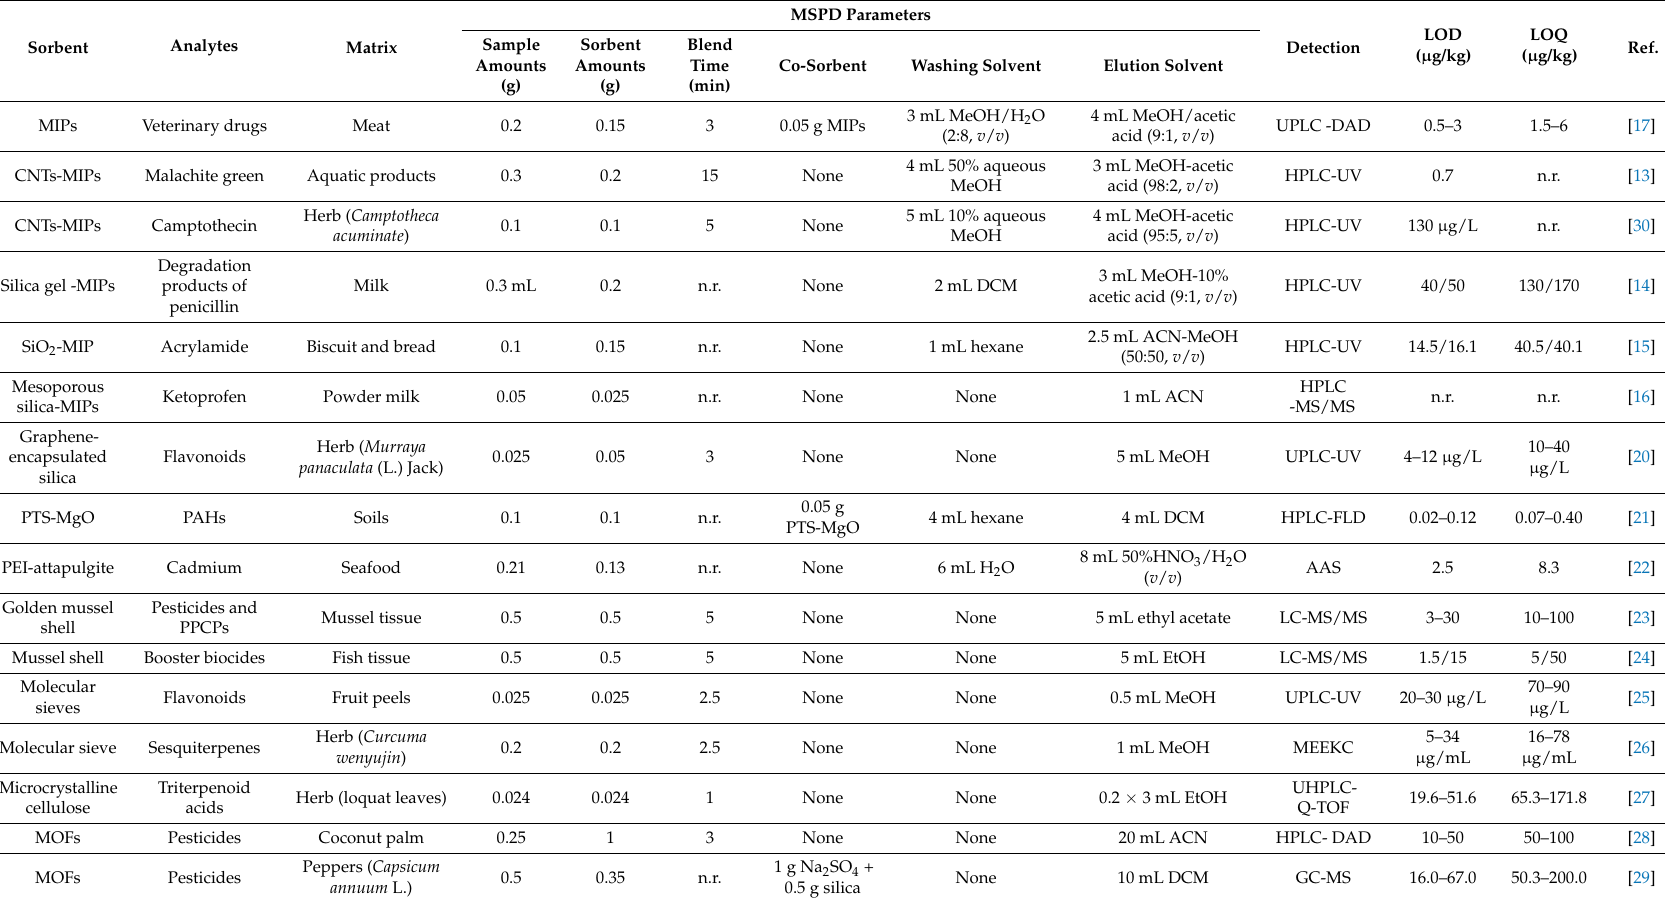
Table 1. Selected representative studies involving developments in MSPD